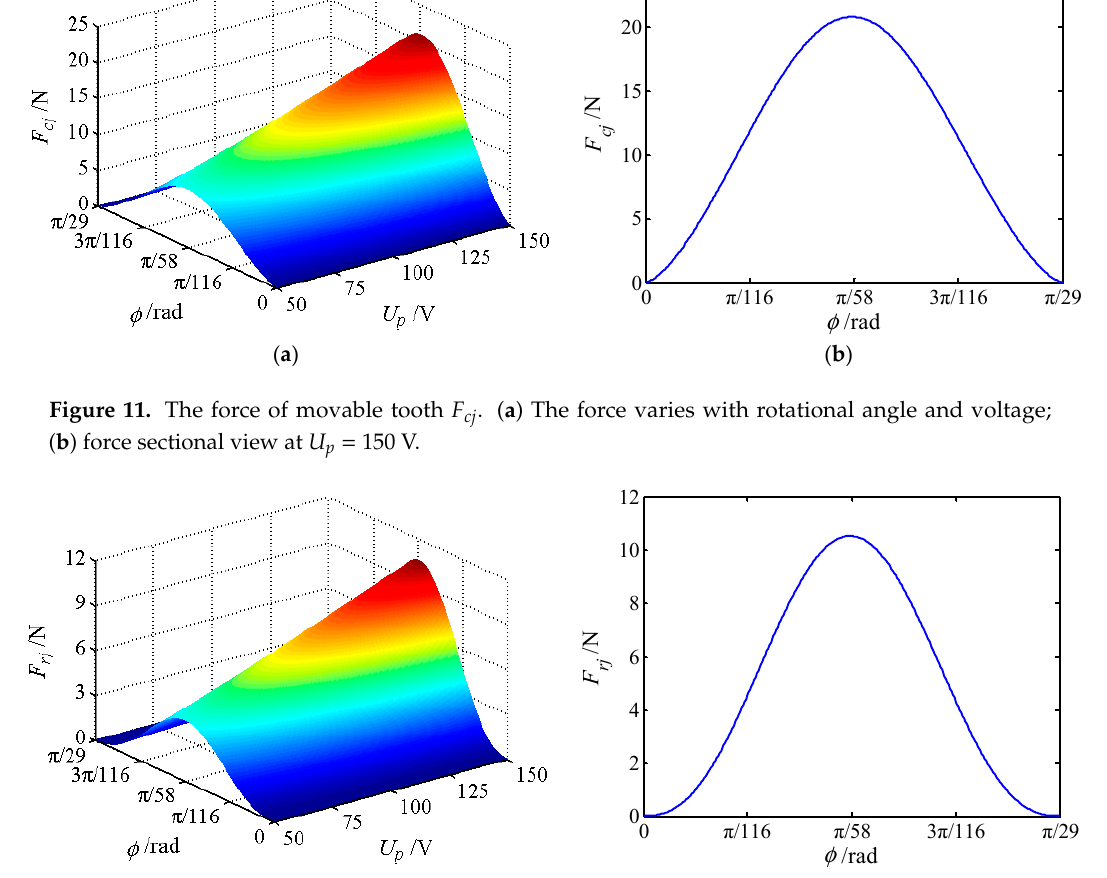
Figure 12. The force of movable tooth F rj . ( a ) The force varies with rotational angle and voltage; ( b ) force sectional view at U p = 150 V. Table 1. Number of meshing movable teeth of different positions in a period.